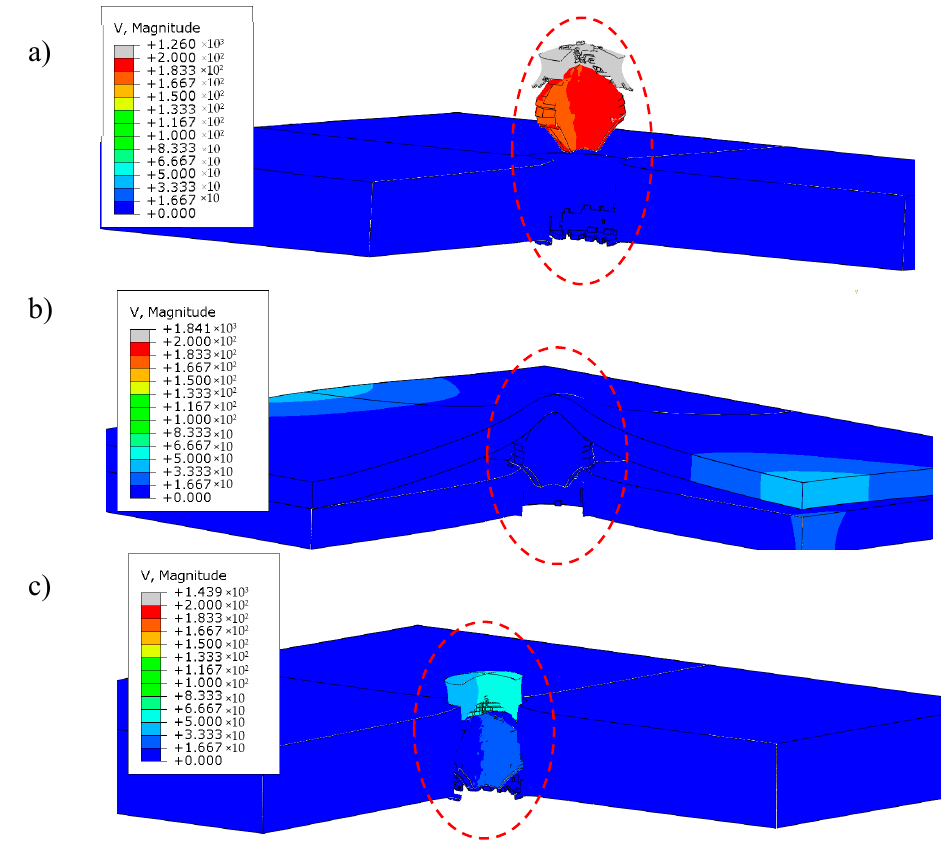
Figure 14. Comparison of FEM results for samples with a thickness of ( a ) 10 mm single, ( b ) 10 mm split, ( c ) 12 mm split, ( c ) 12. mm single.